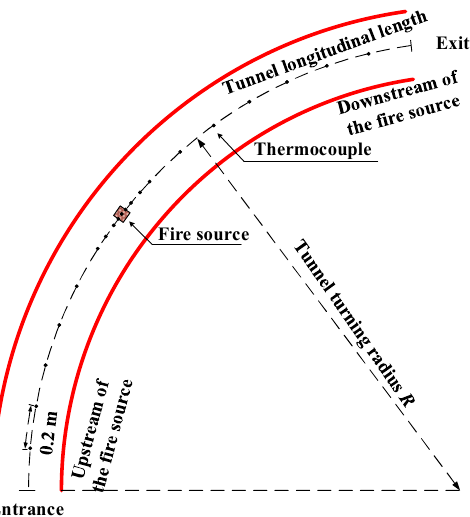
Figure 2. Thermocouple arrangement in a small-scale curved tunnel.